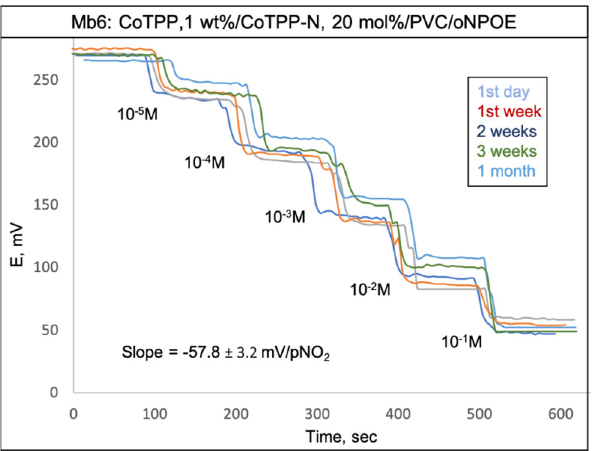
Figure 8. Dynamic response curves of electrodes with membrane Mb6 containing 1 wt.% of CoTPP and 20 mol% of CoTPP-N in NaNO 2 solutions through one month of exploitation. Measurements were carried out in MES buffer, pH 5.5.